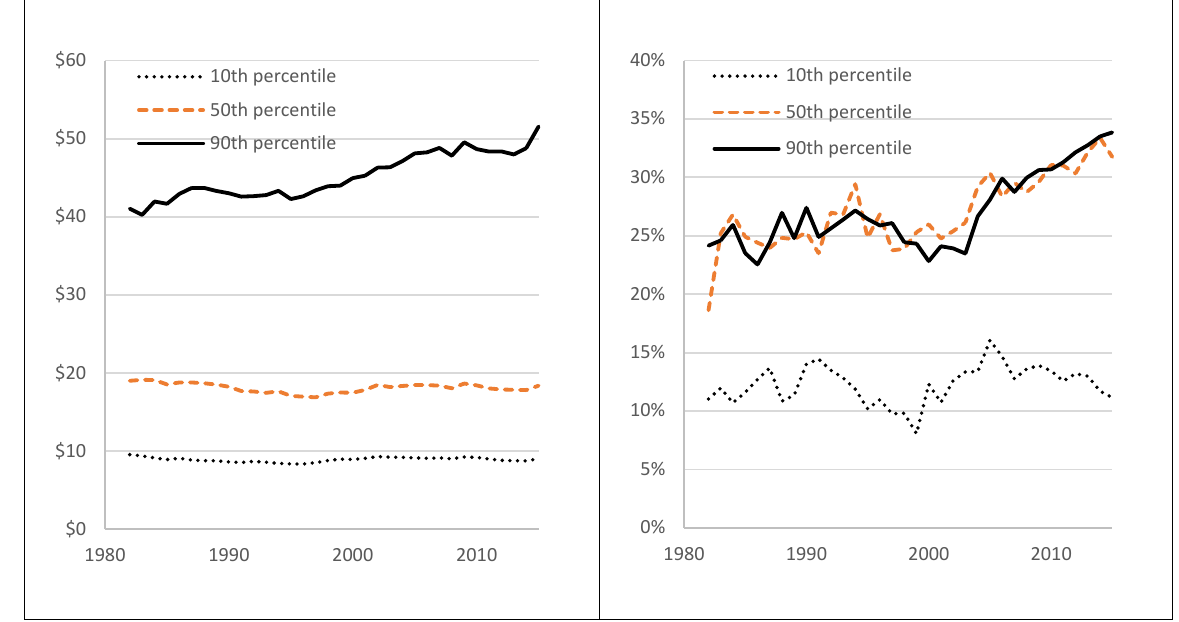
Figure 8: Wages per hour (in constant 2015 dollars) and the ratio of voluntary benefits to wages in the 10th , 50th, and 90th wage percentiles. Note: Private industry (and state and local government sector) wage and salary workers aged 18 to 65 who worked at least 20 hours per week and 26 weeks per